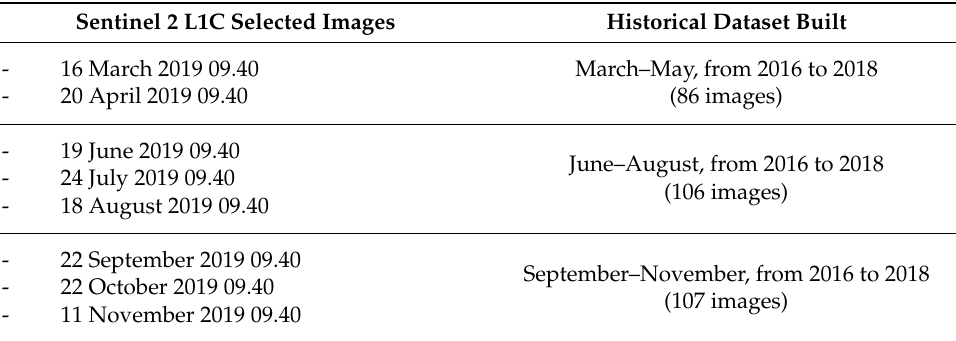
Table 1. Sentinel 2-L1C selected images and relative historical